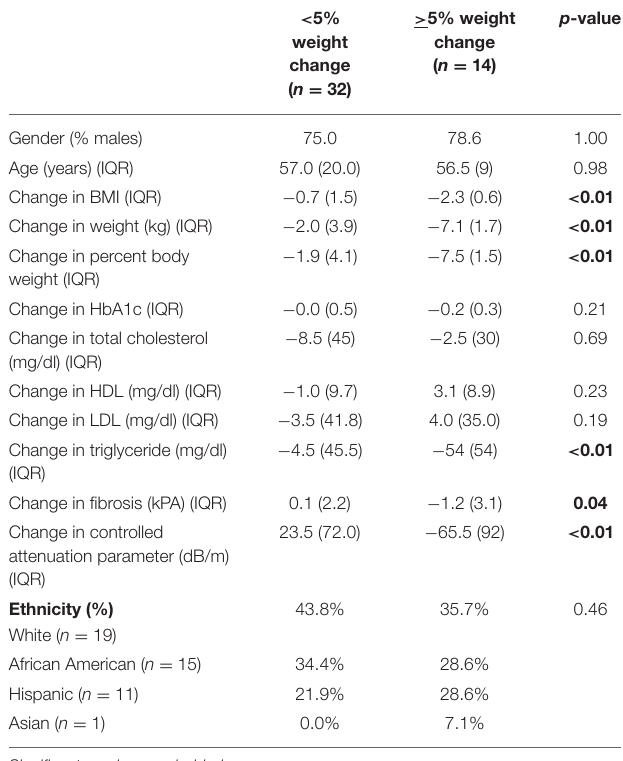
TABLE 2 | Macronutrient intake at baseline and at the final visit as measured by the Diet History Questionnaire III.